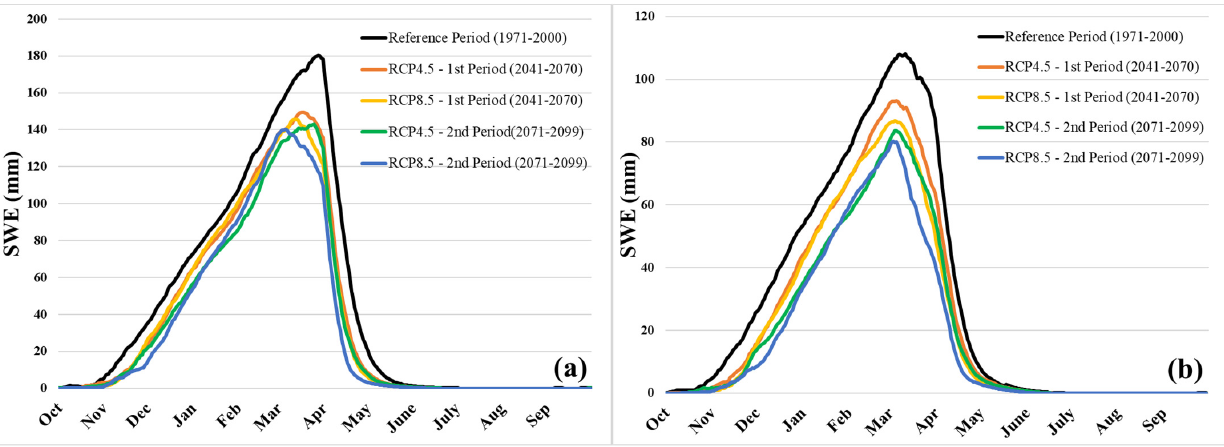
Figure 10. Average SWE values for reference, 1st (2041–2070) and 2nd (2071–2099) periods in RCP4.5 and RCP8.5 emission scenarios for ( a ) Murat and ( b ) Karasu basins. Table 12. Detecting climate change impacts for snow outputs in different scenarios and periods.